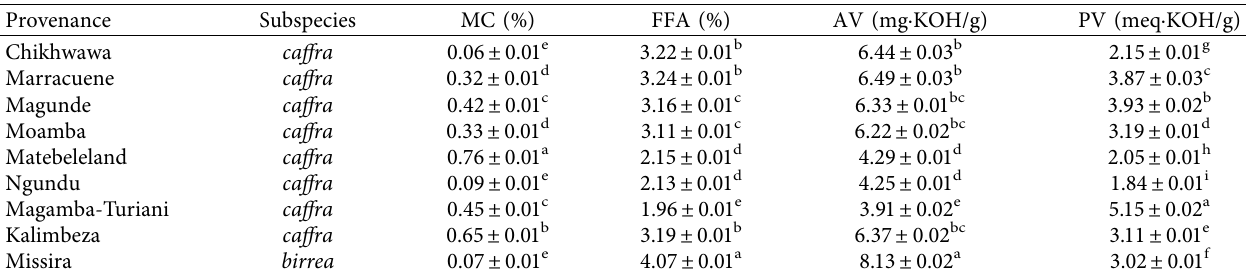
Table 2: Physicochemical properties of S. birrea (subspecies cafra and birrea) seed oil among nine